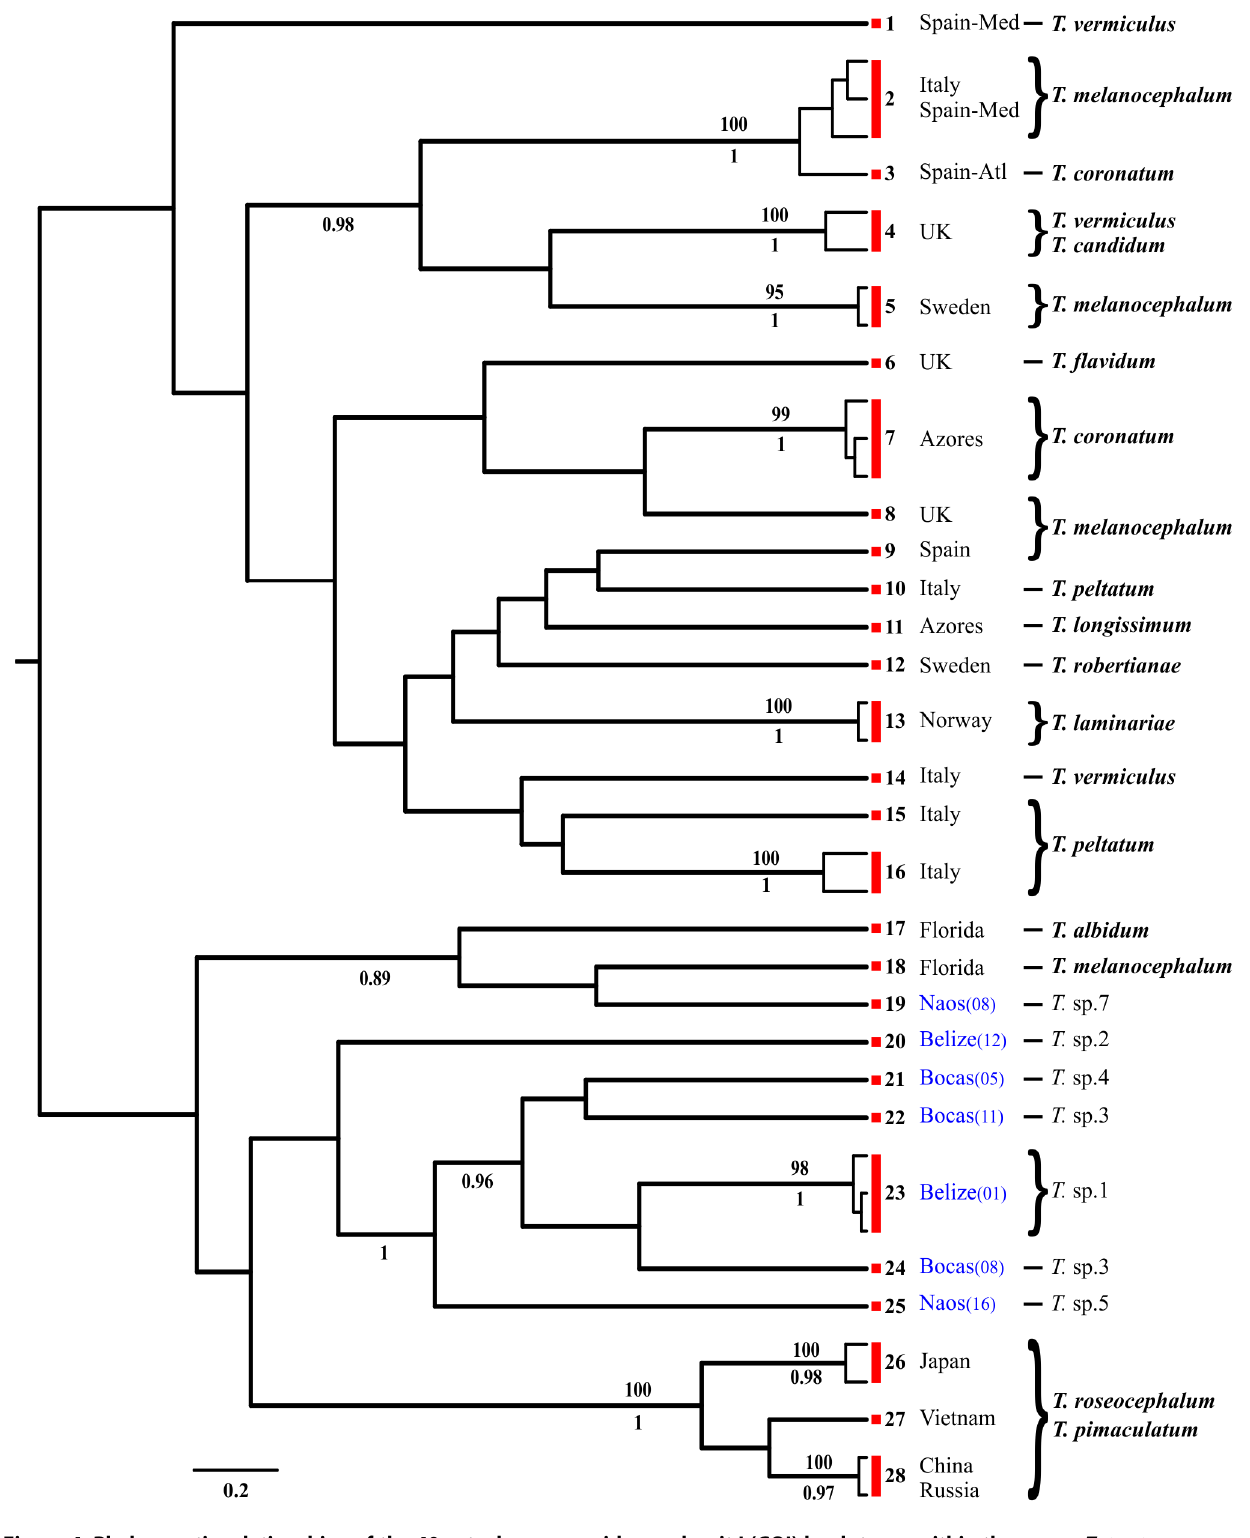
Figure 4. Phylogenetic relationships of the 40 cytochrome c oxidase subunit I (COI) haplotypes within the genus Tetrastemma spp. The consensus of 75,000 sampled trees from Bayesian analysis of the COI data sets is shown, displaying all compatible groupings, with average branch lengths proportional to numbers of substitutions per site under a general time reversible + I + G substitution model. Posterior probabilities from the Bayesian reconstruction and bootstrap support from the maximum likelihood reconstruction are shown below and above each branch, respectively. Support values are not shown for values below 0.8 for posterior probabilities, 80 for bootstrap support and for within-species short branches. Each species is indicated and grouped with a red box at left of tips, on its right the relative number of the entity (E.). Localities are shown